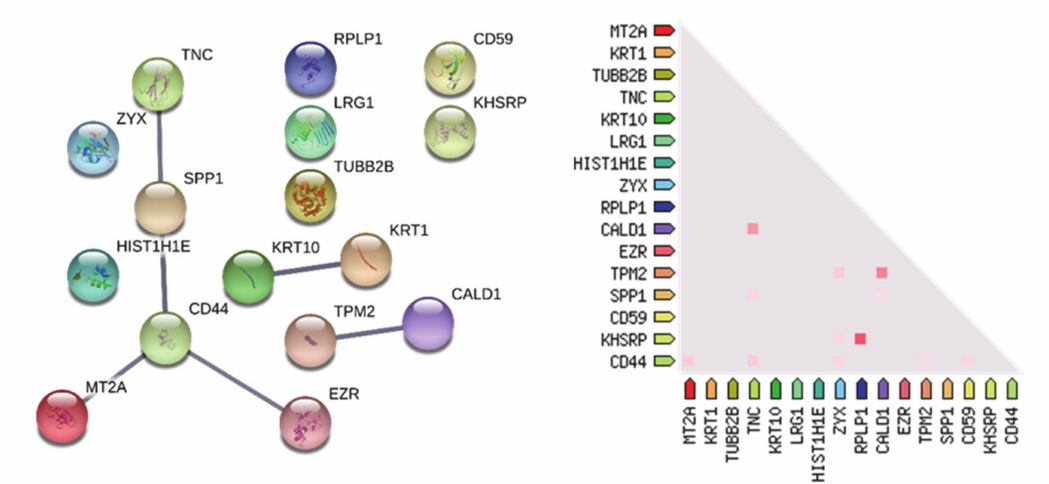
Figure 5. Protein-protein functional interaction network (medium confidence) of the 9 + 8 proteins discriminatory of the CORE tumor zone. The higher the thickness, the higher the confidence of the interaction. On the left the co-expression of the proteins in Homo sapiens is